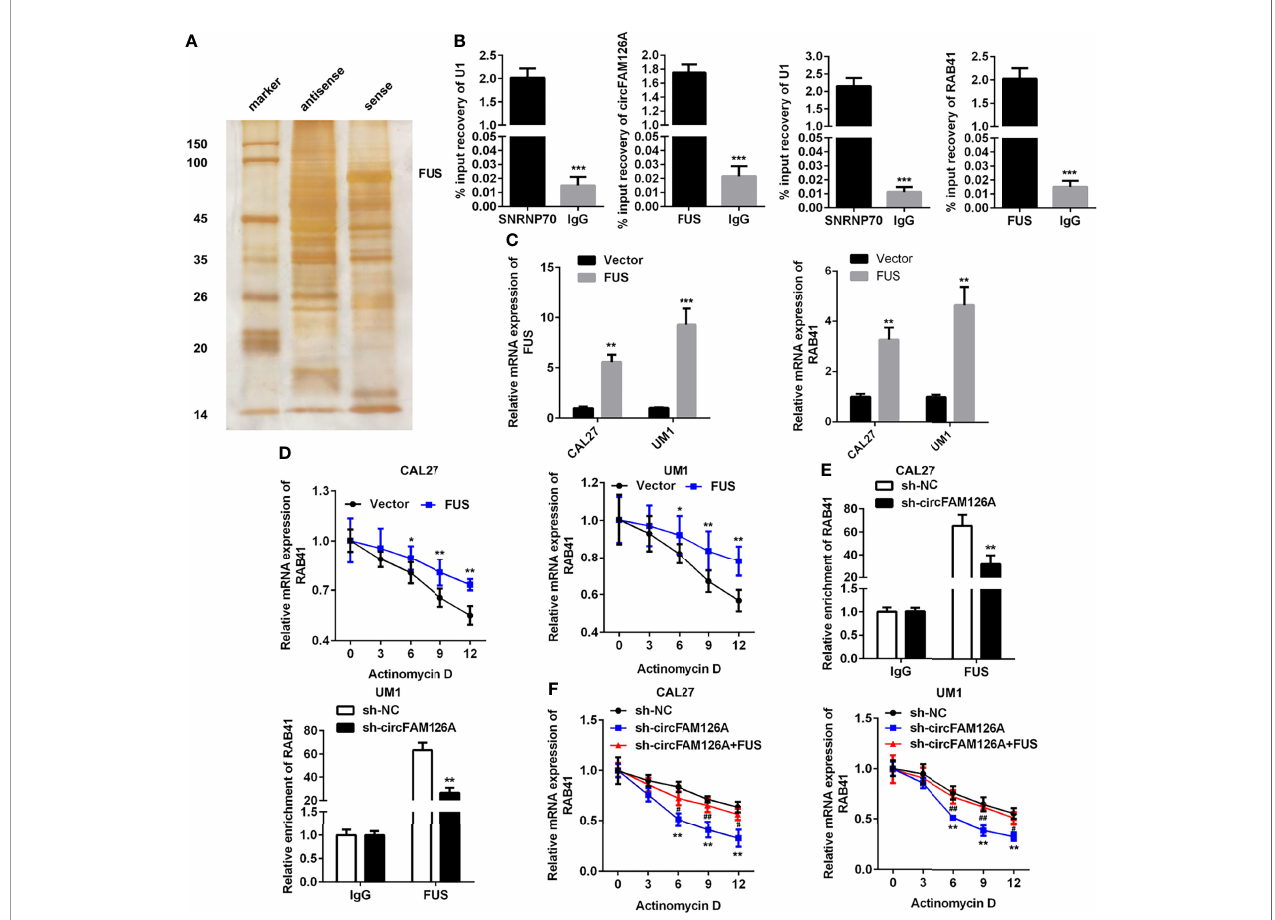
FIGURE 7 | circFAM126A binds to FUS to promote the mRNA stability of RAB41. (A) The potential proteins interacting with circFAM126A detected using RNA pull-down. (B) Interaction between FUS and circFAM126A or RAB41 con fi rmed by RIP assay. (C) mRNA expression of FUS and RAB41 detected by qRT-PCR. (D) mRNA stability of RAB41 determined using qRT-PCR. (E) Interaction between FUS and circFAM126A or RAB41 veri fi ed by RIP assay. (F) mRNA stability of RAB41 determined using qRT-PCR. * P <0.05, ** P <0.01 and *** P